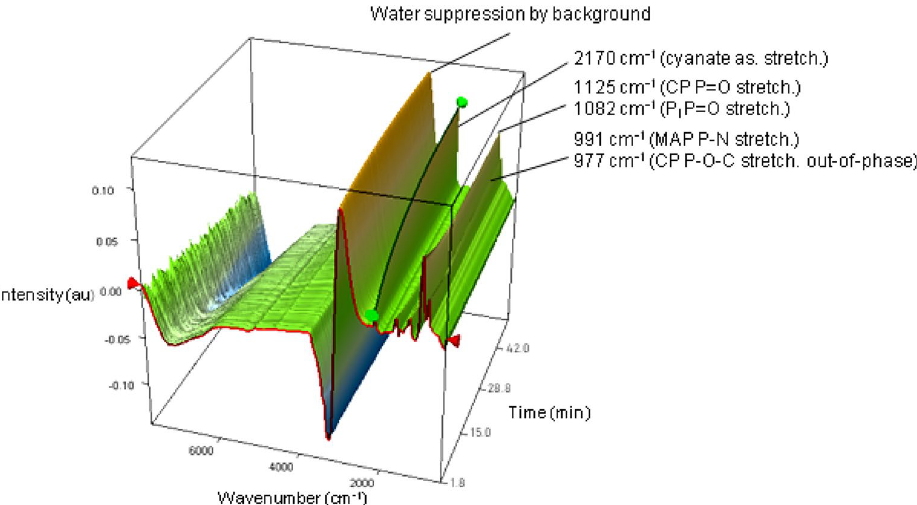
Figure 2. Stacked ATR-IR spectra of the CP kinetics in ammonia. The green highlighted curve corresponds to the evolution of the cyanate band.